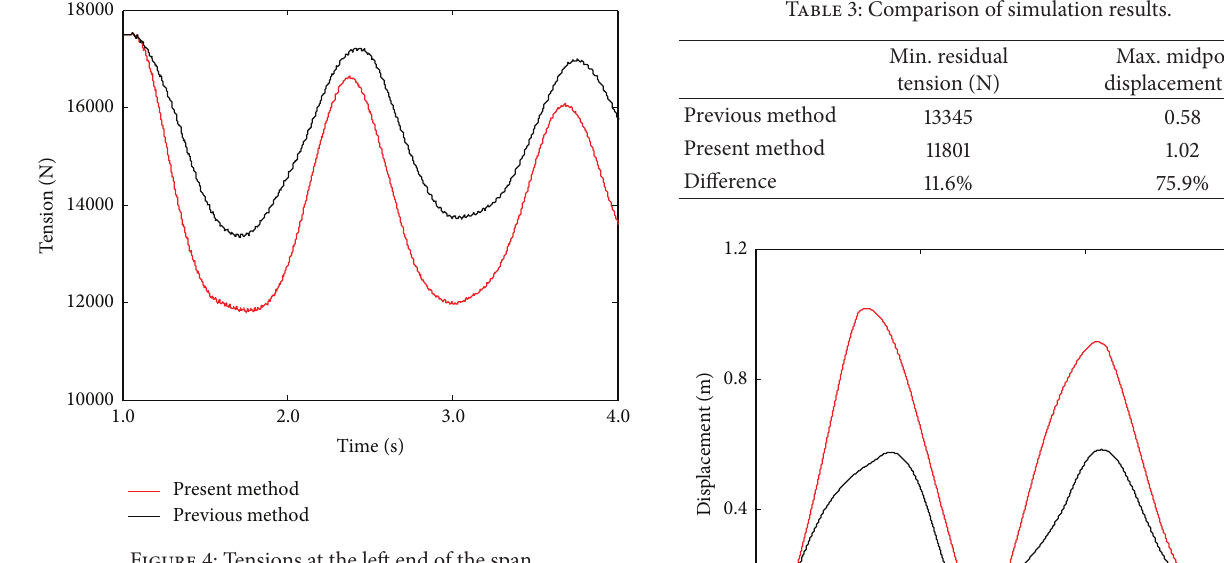
Figure 4: Tensions at the left end of the span.